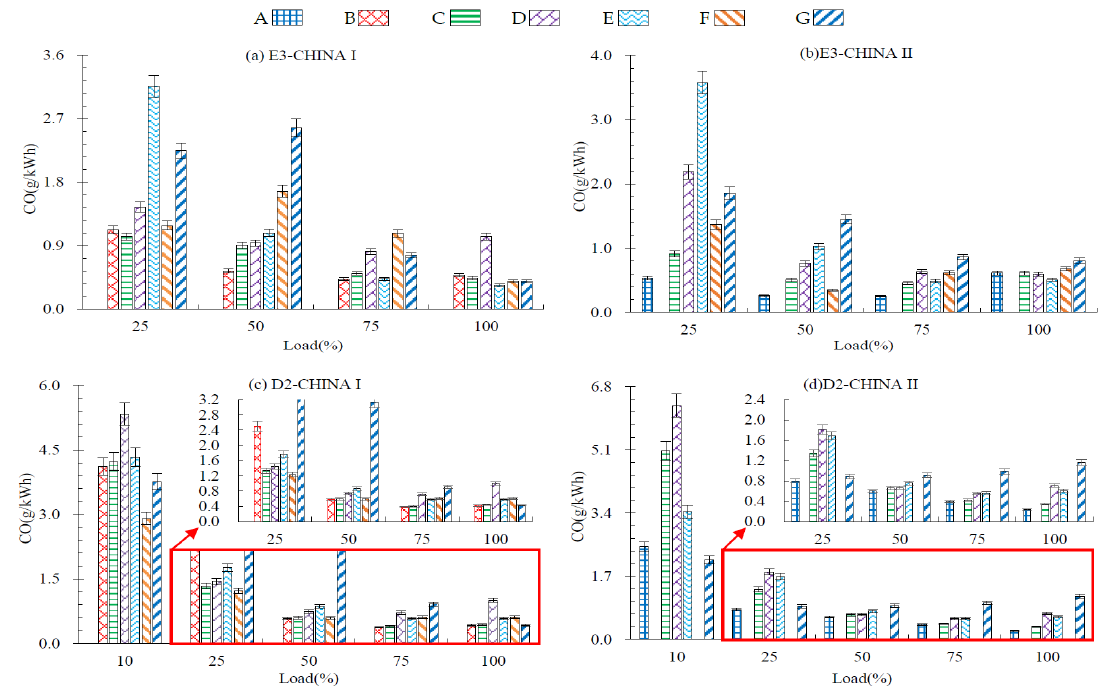
Figure 8. Relationship of CO energy-based emission factors against load. ( a ) Specific emissions in the E3 cycle at four load points under the CHINA I standard; ( b ) Specific emissions in the E3 cycle at four load points under the CHINA II standard; ( c ) Specific emissions in the D2 cycle at five load points under the CHINA I standard; ( d ) Specific emissions in the D2 cycle at five load points under the CHINA II